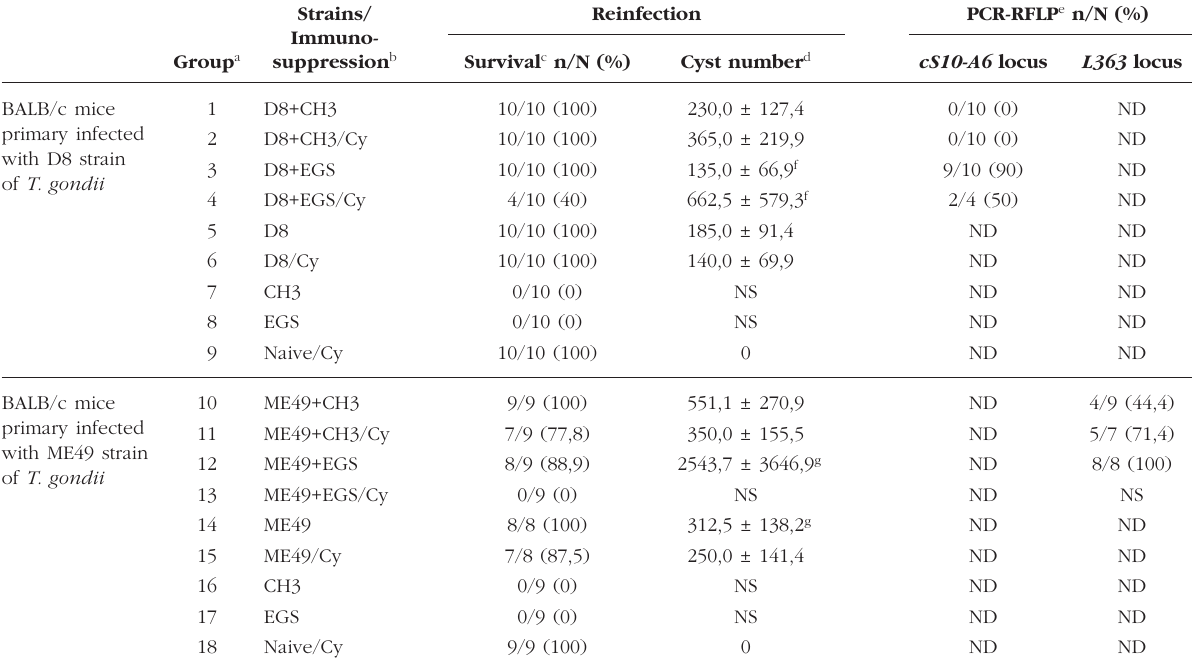
Table II. – Survival, brain cysts and PCR of BALB/c mice primary infected with the D8 or ME49 strains, immunosuppressed or non-immuno- suppressed with cyclophosphamide (Cy), and challenged 45 days after primary infection with the CH3 or EGS strains of Toxoplasma gondii